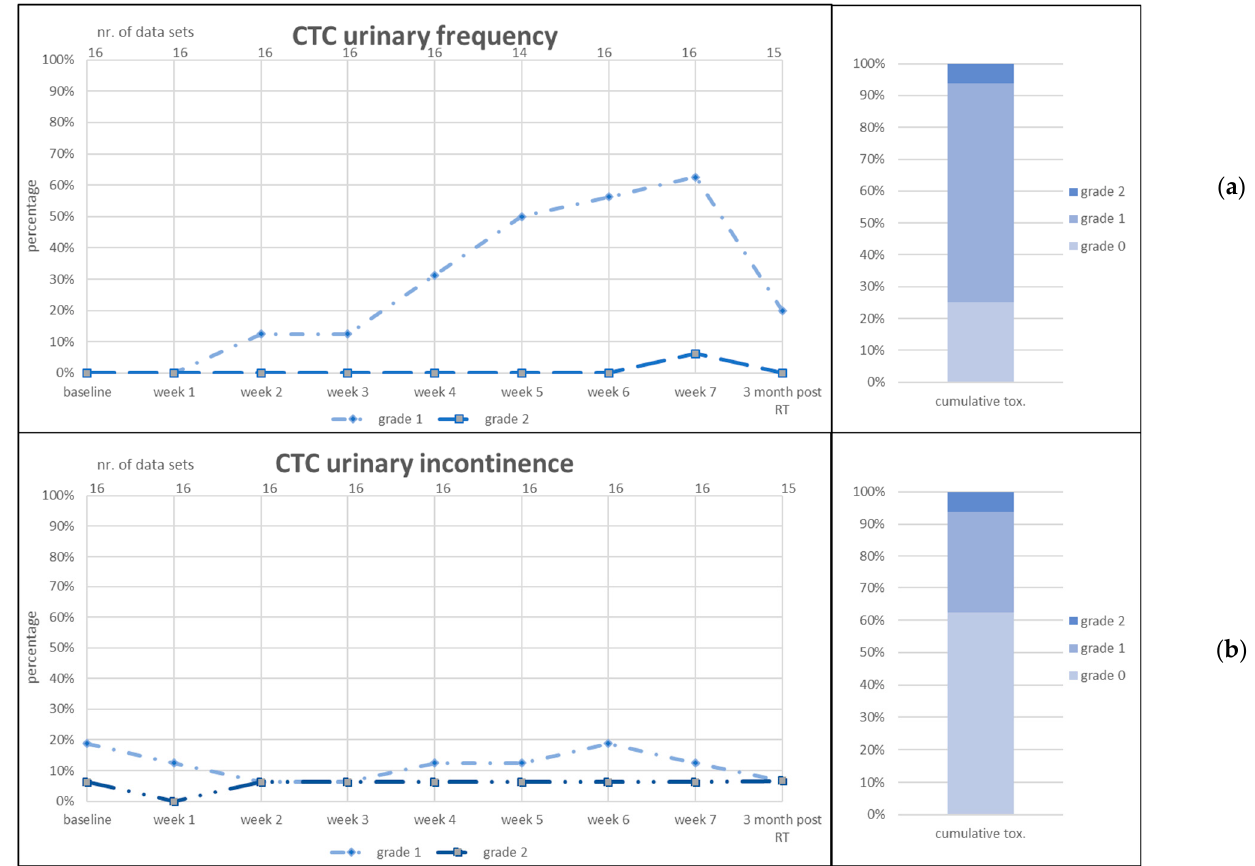
Figure 4. Acute genitourinary (GU) toxicity scored as CTC urinary frequency ( a ) and CTC urinary incontinence ( b ). RT = radiotherapy. Left graphs: number of patients in percent ( y -axis) who reported the toxicity item at the given point of time (lower x -axis). Number of data sets in upper x -axis. Right graphs: cumulative toxicity of the given item up to 3 months post RT.